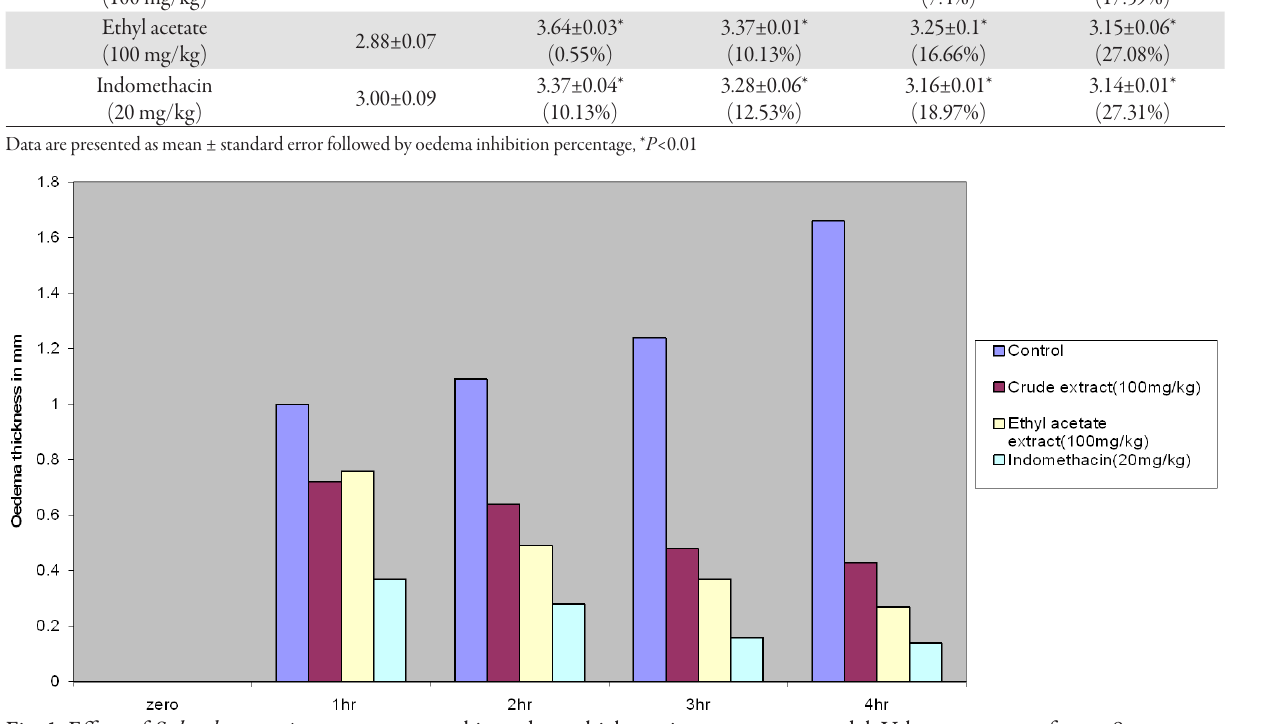
Fig. 1. Effect of Salvadora persica extracts on rat skin oedema thickness in carrageenan model. Values are mean of n,